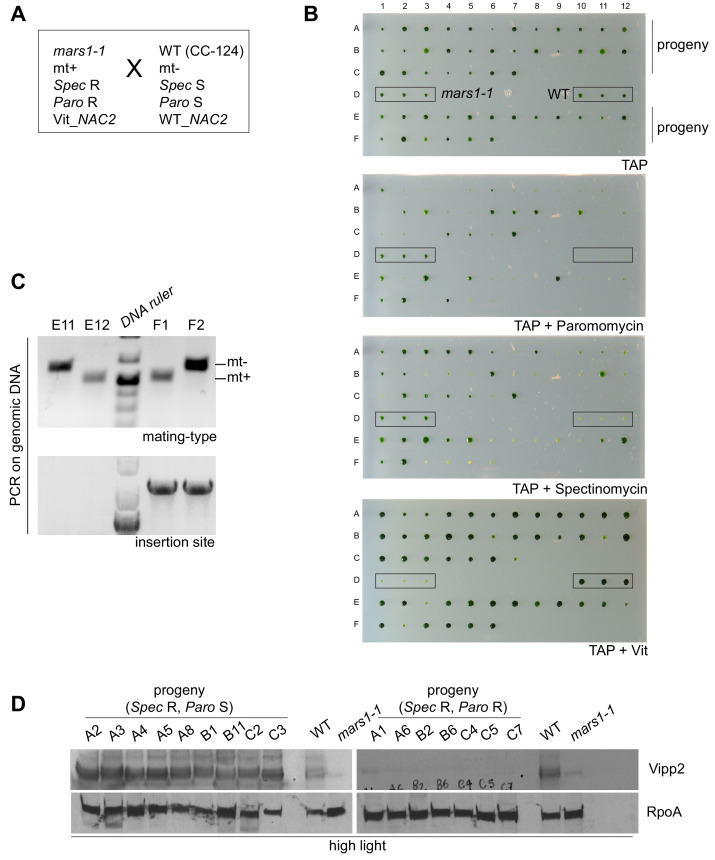
Genetic analysis of mars1-1.(A) Diagram showing the backcross of mars1-1 to CC-124 (WT) and indicating the mating-type and other genetic markers of these two strains. The spectinomycin resistance (Spec R) and the Vit-driven NAC2 transgene (Vit-NAC2) are linked to the genetic modifications introduced into the chloroplast and in the nuclear genome, respectively, to generate a Vit-driven ClpP1 repressible strain (Ramundo et al., 2014; Ramundo et al., 2013). The paromomycin resistance (Paro R) is linked to the insertion of the mutagenic cassette into the nuclear genome. (B) Photographs of offspring from the mars1-1 x CC-124 (WT) backcross along with the parental controls, mars1-1 and CC-124, re-arrayed in a 96-well format and replicated on TAP agar or on TAP agar supplemented with Vit, with paromomycin or with spectinomycin. Due to difficulties in the cross, most isolated tetrads were incomplete. However, among the spectinomycin resistant offspring, about 50% of the cells were found to be paromomycin resistant as expected in the case of Mendelian inheritance of a single nuclear locus. (C) Mating type and insertion site PCR products from genomic DNA samples prepared from a full tetrad progeny obtained from the backcross of mars1-1 to CC-124 (WT) (Werner and Mergenhagen, 1998). The phenotypes of the progeny are shown in Figure 2E. Both the mating-type and the mutagenic cassette, disrupting the MARS1 gene locus, segregated 2:2. (D) Immunoblot analysis of samples prepared from the indicated progeny and exposed to HL, using antibodies against Vipp2 and RpoA as a loading control. Only spectinomycin-resistant progeny were selected, and they were named after their coordinates in the 96-well plates shown in Figure 2—figure supplement 2B.